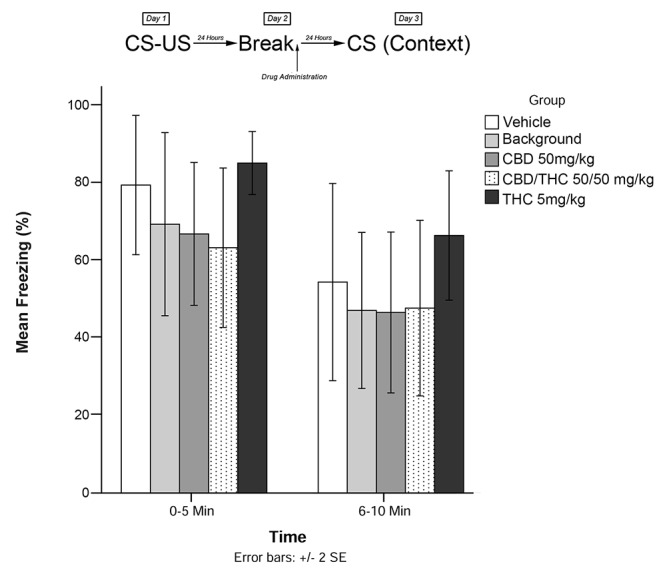
The individual Cannabis extracts on their own had no significant effects on reconsolidation of contextual learned fear 24 h after drug administration in the absence of fearful memory-trace recall.